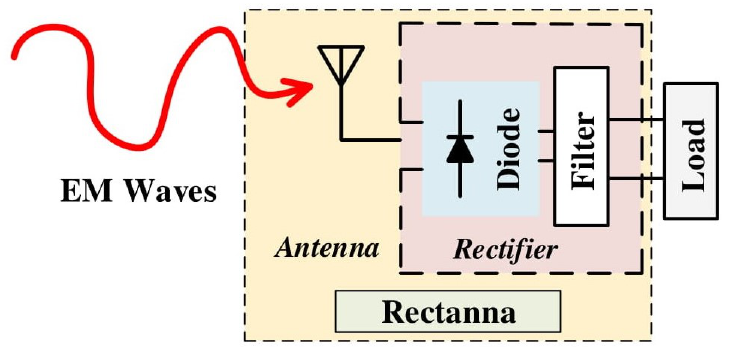
Figure 14. Schematic of the